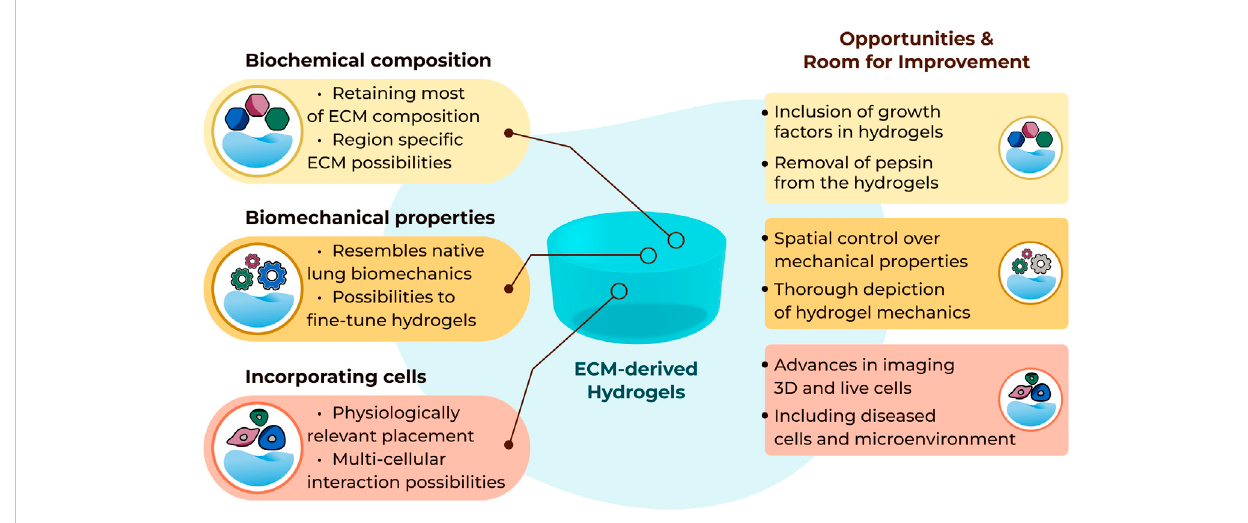
FIGURE 1 Summary of current possibilities and future opportunities with three-dimensional lung ECM-derived